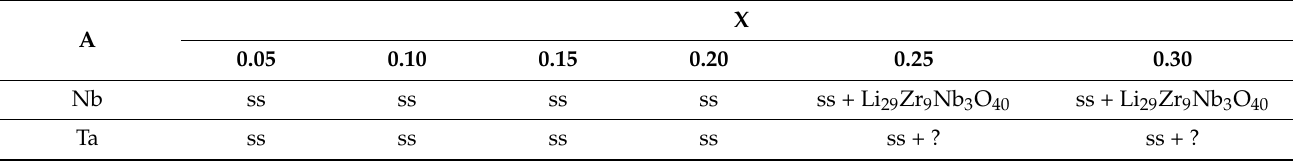
Table 2. Phase composition of Li 6-x Zr 2-x A x O 7 (A = Nb, Ta) samples according to XRD. X A 0.05 Nb ss ss ss Ta ss ss ss ss ss + ? ss + ? ss indicates solid solutions with the monoclinic structure of Li 6 Zr 2 O 7